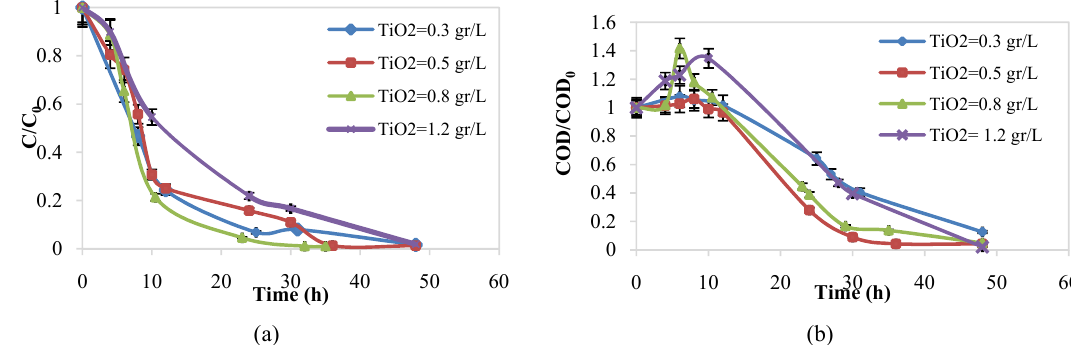
Fig. 4. (a) SDBS concentration to initial SDBS concentration ratio) vs. time in various TiO2 concentrations (b) COD/COD 0 vs. time TiO 2 concentrations (pH=8, [SDBS] = 300 mg/L)